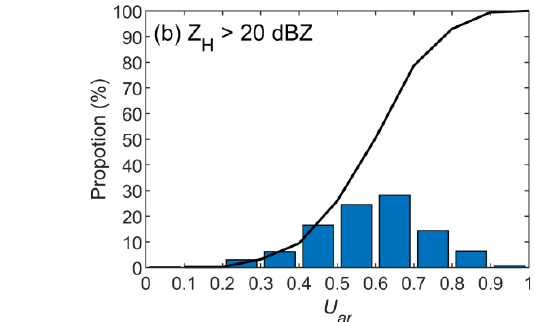
Figure 10. Mean vertical profile in area A. (Statistics by data points with Z H > 0 dBZ).